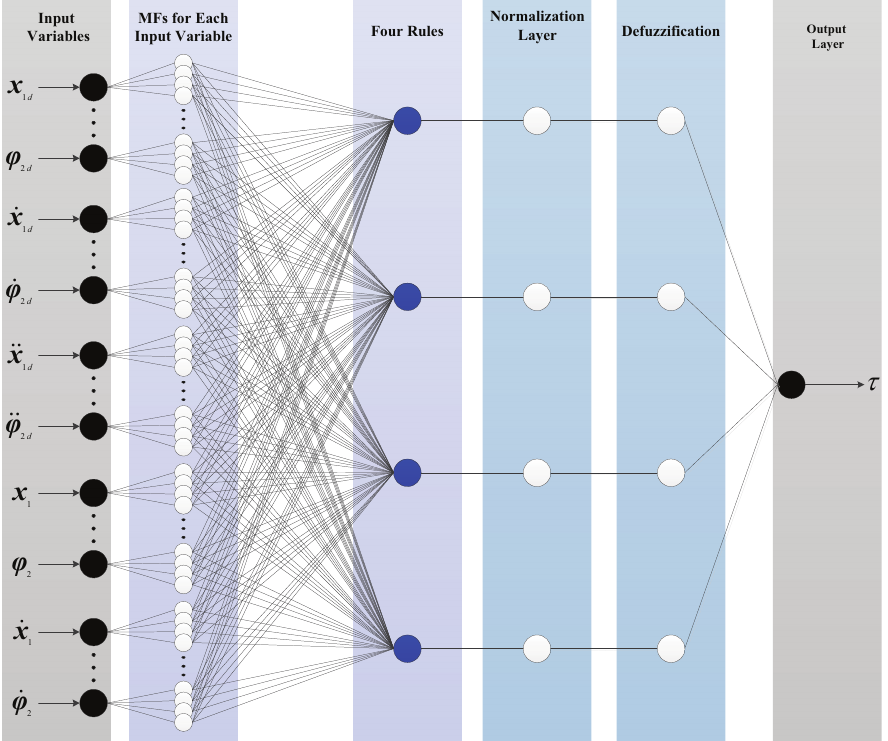
Figure 4. The structure of Takagi–Sugeno model-based adaptive neural network